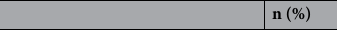
No. of cultured 0PN-derived embryo